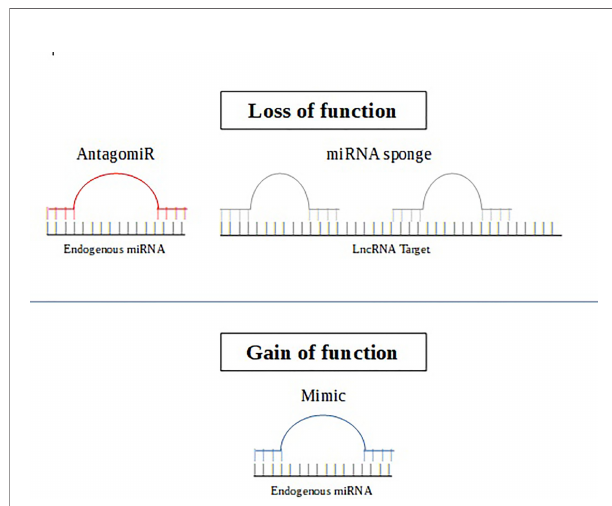
FIGURE 2 | The AntagomiR (in red) is an oligonucleotide sequence complementary to the endogenous target miRNA, leading to functional inhibition. MiRNA sponge (in gray) are RNA transcripts containing binding sites that sequester speci fi c miRNAs to prevent them from interacting with their target sequence. The miRNA mimic (in blue) is an RNA fragment that acts by mimicking an endogenous miRNA that can speci fi cally bind to its target gene.